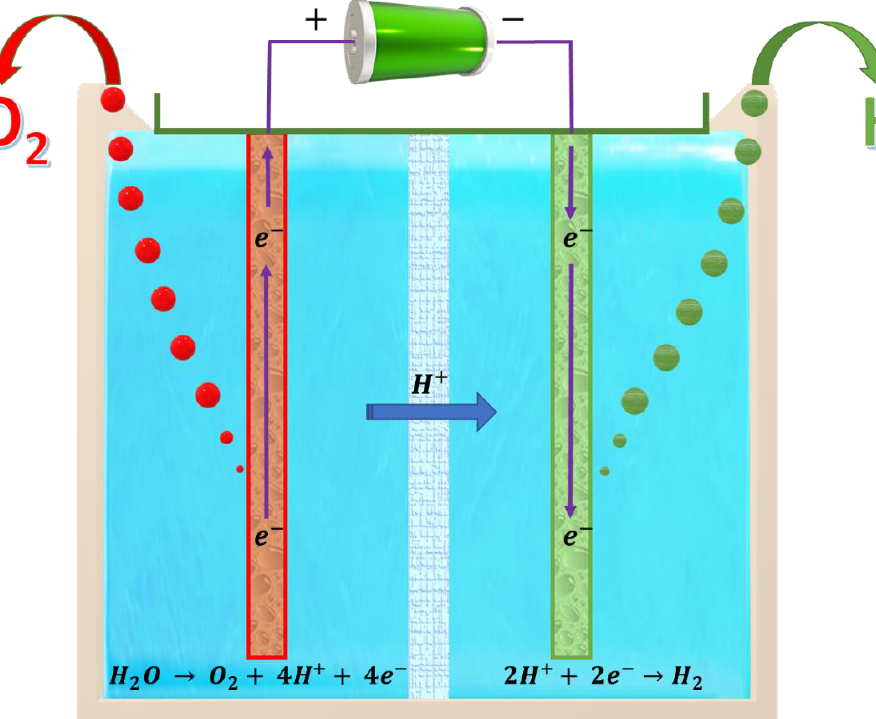
Figure 5. Water-splitting reaction occurring in a model electrolysis cell.